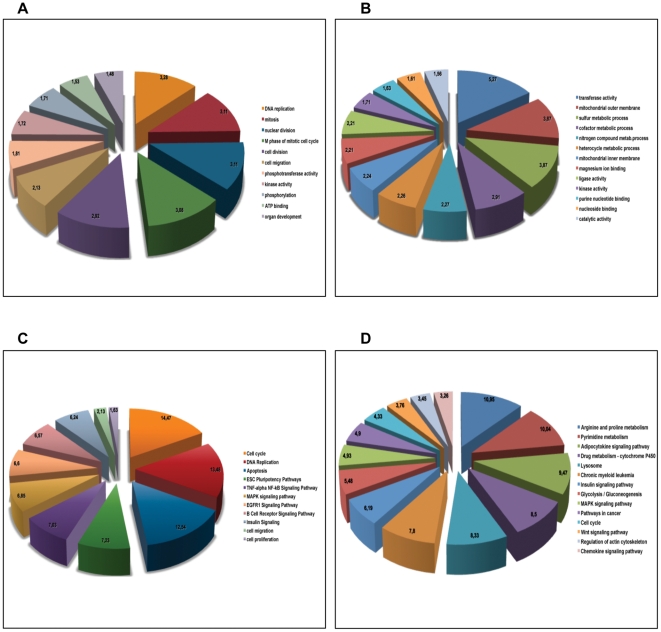
Functional class scoring of the differentially expressed genes.Gene ontology (GO) and pathway functional class scoring have been performed using the Gene Set Analysis Toolkit V2 (http://bioinfo.vanderbilt.edu/webgestalt). A) GO categories enriched for genes down-regulated after Pax8 silencing. B) GO categories enriched for genes up-regulated after Pax8 silencing. C) KEGG (Kyoto Encyclopedia of Genes and Genomes) pathways enriched for genes down-regulated after Pax8 silencing. D) KEGG pathways enriched for genes up-regulated after Pax8 silencing.